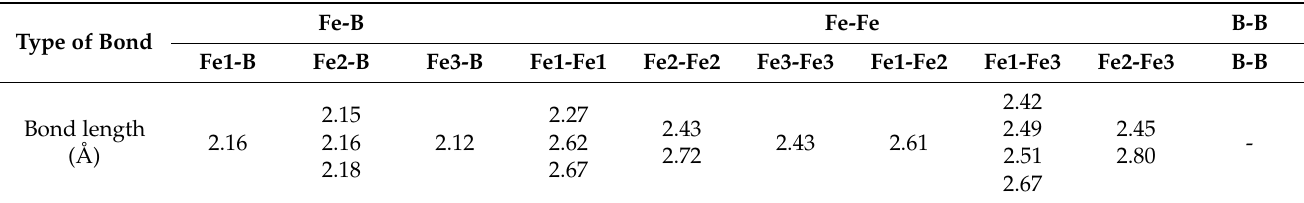
Table 2. Types of bond and their bond lengths in Ni 3 P-type Fe 3